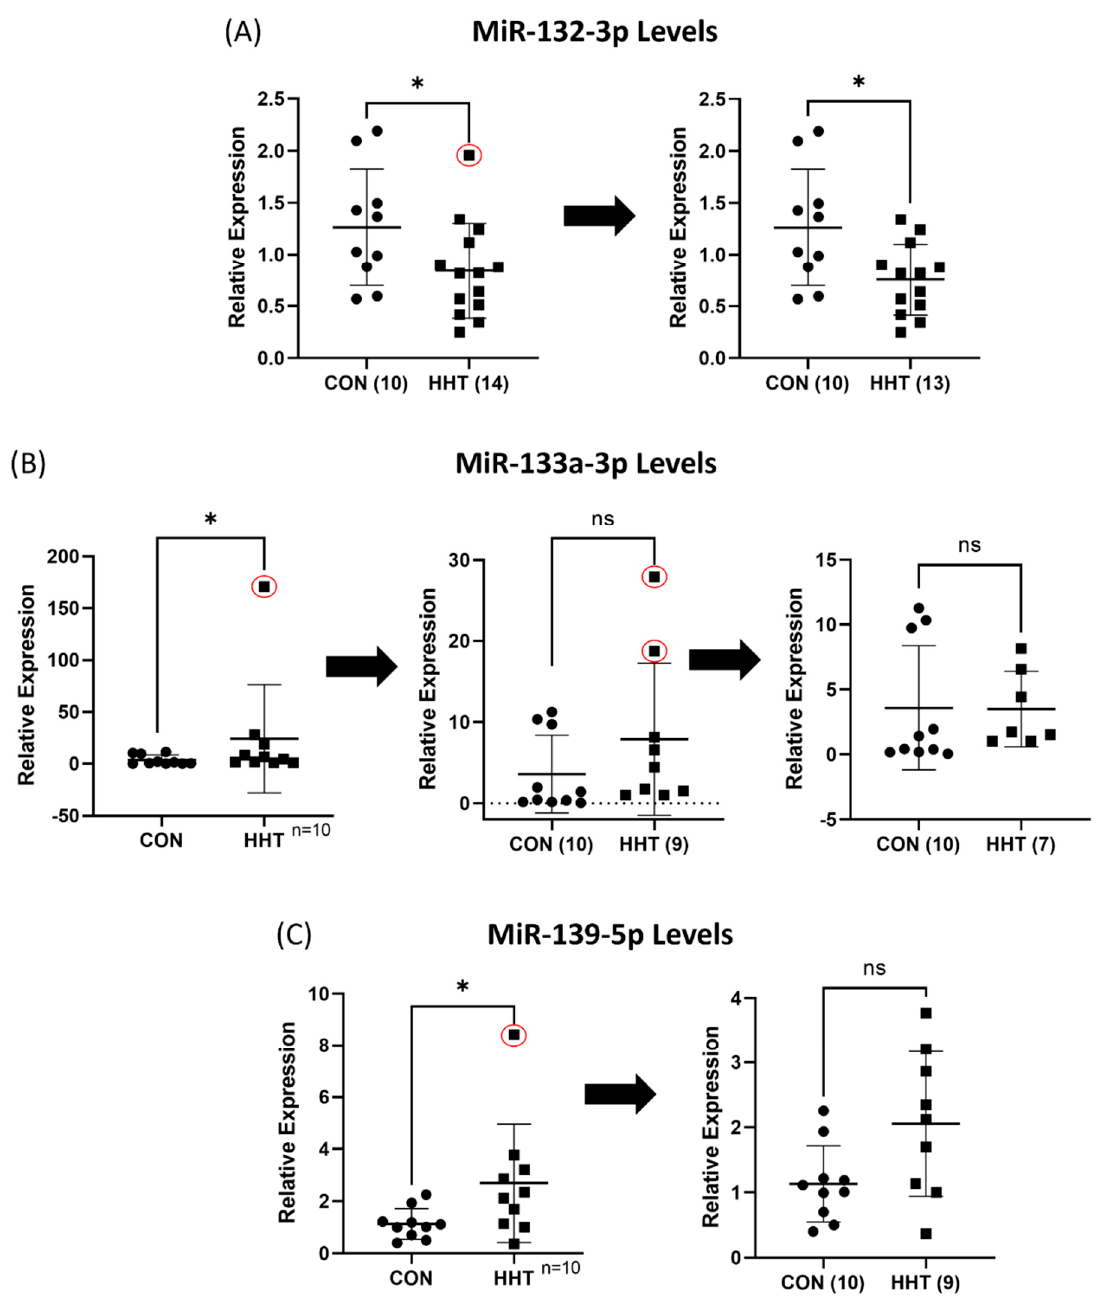
Figure 6. Z-score analysis of outliers. Removal of outliers (circled in red) by Z-score analysis did not result in loss of statistical significance in miR-132-3p ( A ) but in miR-133a-3p ( B ) and miR-139-5p ( C ). * p < 0.05 and ns indicates not statistically significant.